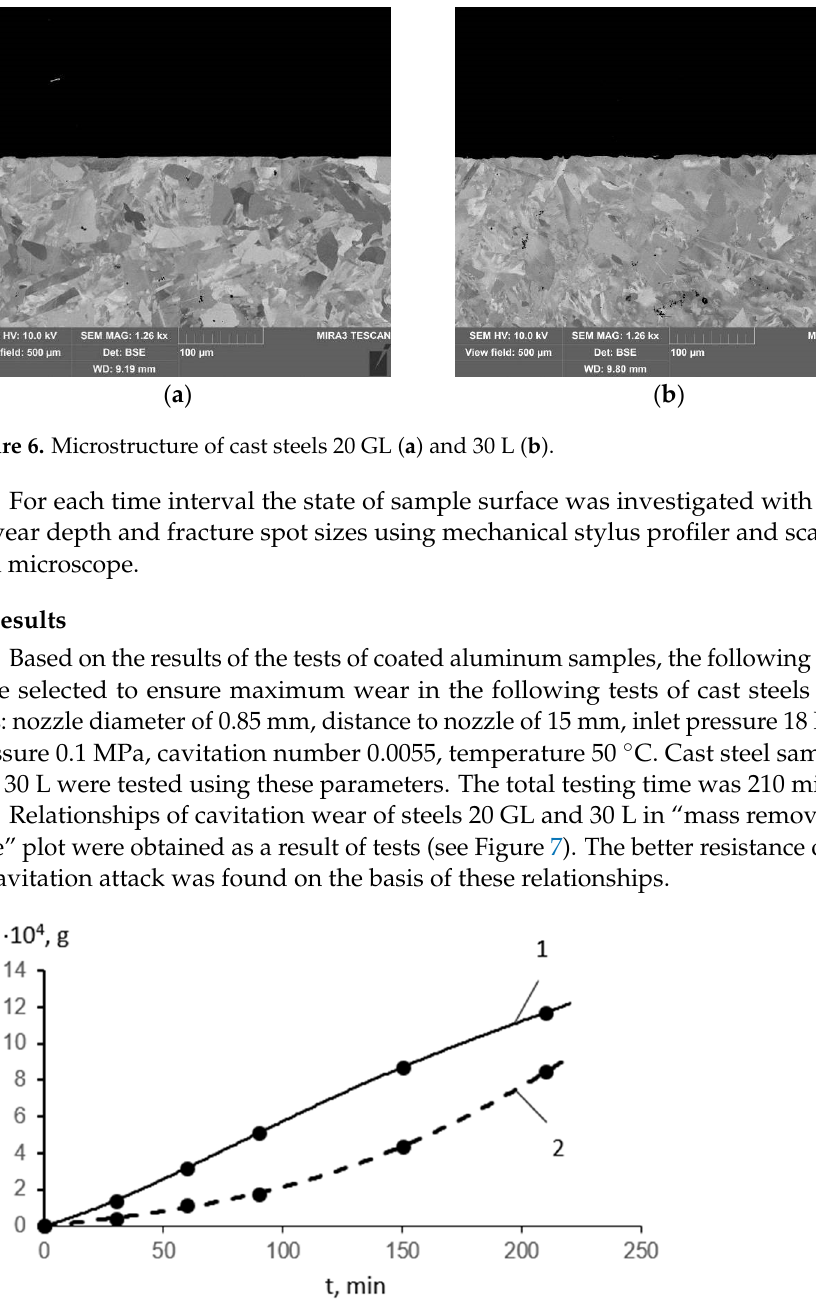
Table 5. C hemical composition and hardness of steels 20 GL and 30 L.